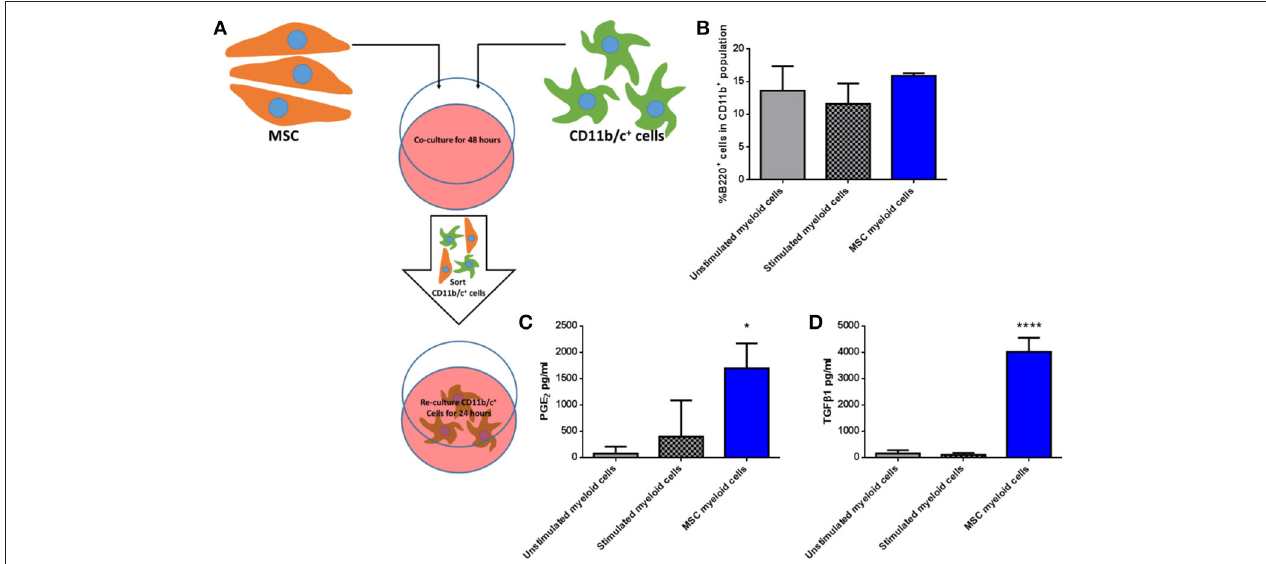
FIGURE 5 | Allogeneic MSC polarize macrophages to a more immunomodulatory phenotype in vitro (A) Schematic representation of the co-culture of CD11b/c + (myeloid) cells isolated from Lewis rat lungs with Wistar Furth MSC or control conditions for 48h followed by re-purification and culture for 24h. (B) Graph of the proportions of B220 + cells among CD11b + cells following 48h culture Lewis rat lung myeloid without further stimulus (Unstimulated myeloid cells), with IFN γ /LPS stimulation (Stimulated myeloid cells) and with Wistar Furth MSC (MSC myeloid cells). (C,D) Graphs of the concentrations of PGE 2 (C) and TGF β 1 (D) in 24h culture supernatants of CD11b/c + Lewis rat lung myeloid cells re-purified from the same three 48-h culture conditions. All results are presented as mean ± SEM with n = 3 in each group. Statistical analyses were performed using one way ANOVA with Tukey’s post-test, * p < 0.05, **** p <